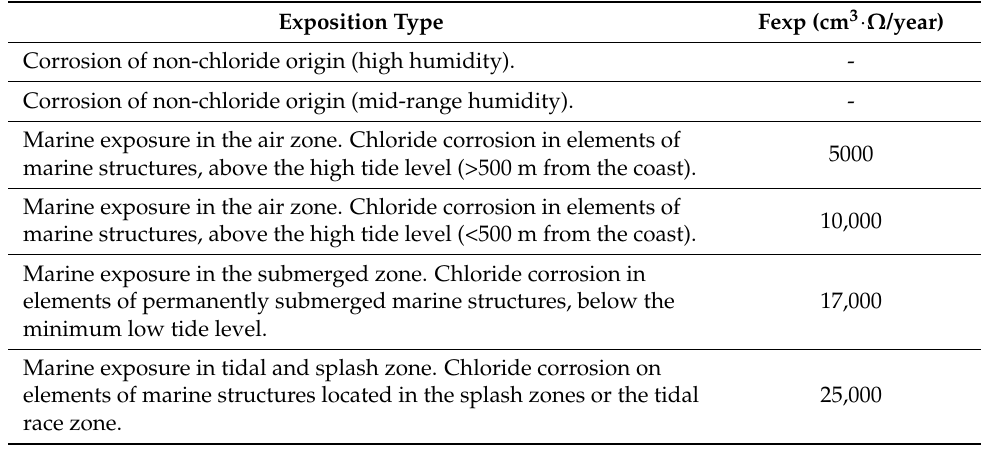
Table 2. Environmental exposure factor (F exp ) values as a function of the type of environmen- tal